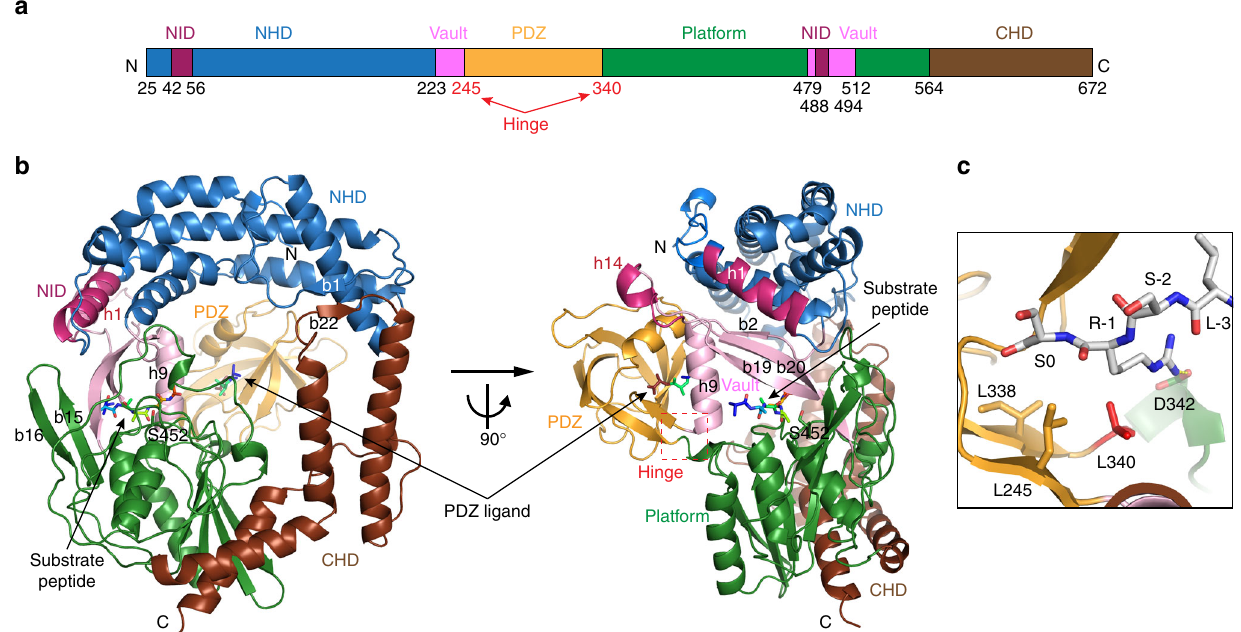
Fig. 4 Overall structure of Prc. a Domain organization of Prc. NHD and CHD denote the Prc-speci fi c N- and C-terminal helical domains, respectively. NID denotes NlpI-interaction domain. b Two orthogonal views of Prc. Only one of the two Prc molecules (chain C) in the structure is shown. c A zoomed-in view of the co-crystallized peptide bound to the PDZ domain and interacting with hydrophobic residues at the hinge. The peptide bound to chain C is modeled as the MepS C-terminal tetrapeptide LSRS-COOH, of which the penultimate residue (R-1) forms a hydrogen bond with